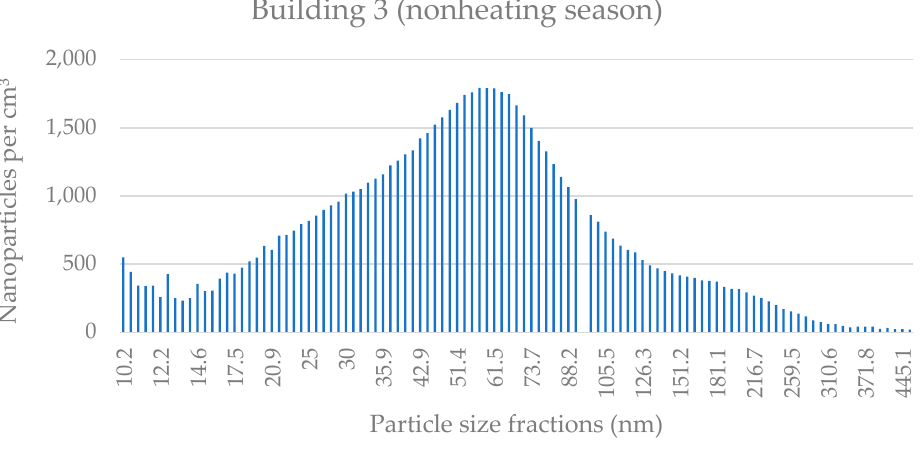
Figure A5. The average nanoparticle concentration in each size fraction in Building 3 during a one-week measurement period during the heating season.